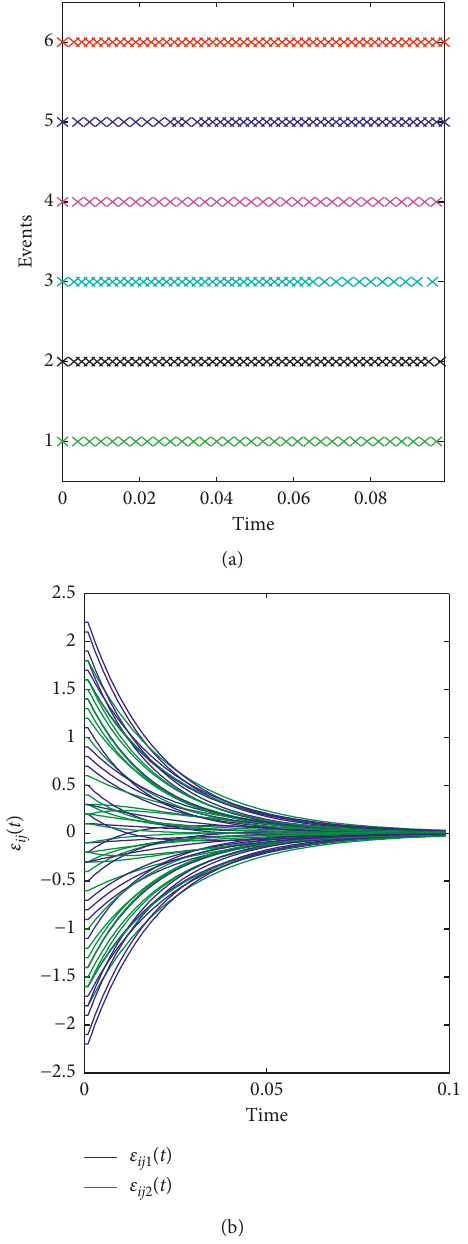
Figure 5: Time evolutions of the event-triggered controller and the synchronization errors in Example